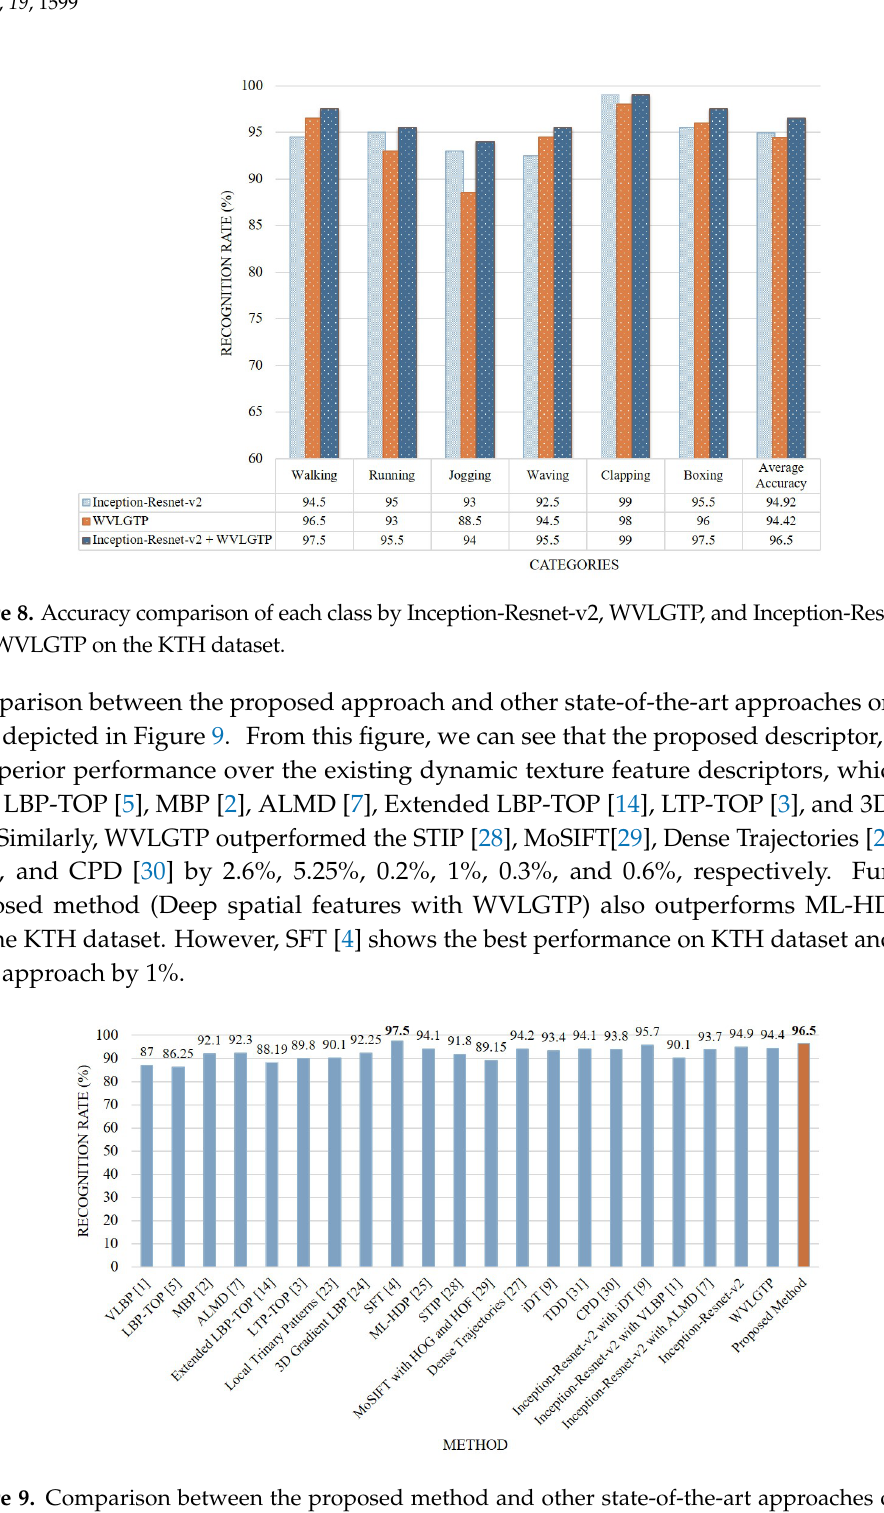
Figure 9. Comparison between the proposed method and other state-of-the-art approaches on the KTH